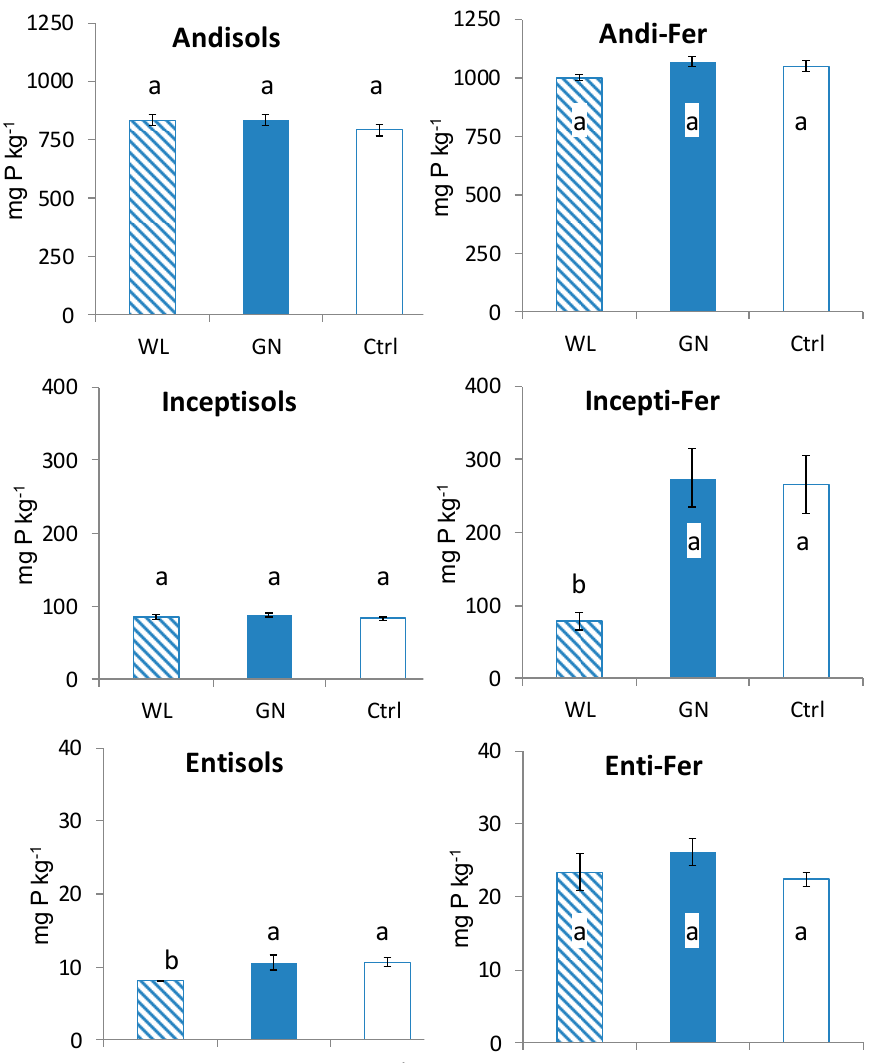
Figure 3. Less labile Po (NaOH extractable Po) of white lupin (WL), groundnut (GN) rhizosphere soil, and of control (Ctrl) soil. Different letters indicate significant difference among WL, GN and Ctrl according to Tukey test ( p < 0.05).